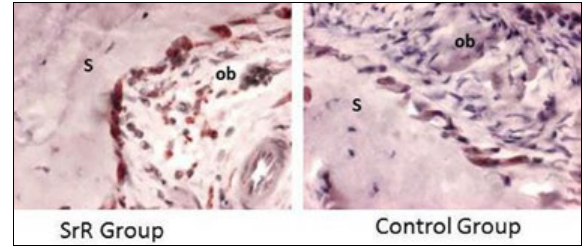
Figure 4. Photomicrographs of immunohistochemical sections from sutural areas stained with anti-osteonectin antibody. Ob: Osteoblastic activity; S: Sutura connective tissue (40× magnification).